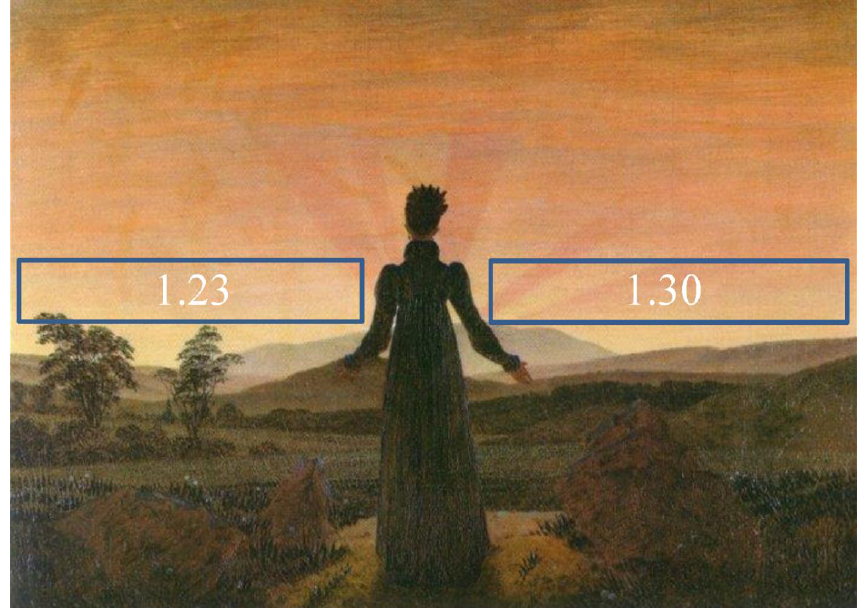
Fig. C3. Caspar David Friedrich, Woman in front of the Setting Sun, 1818. Corresponding R/G ratios were averaged inside each box.